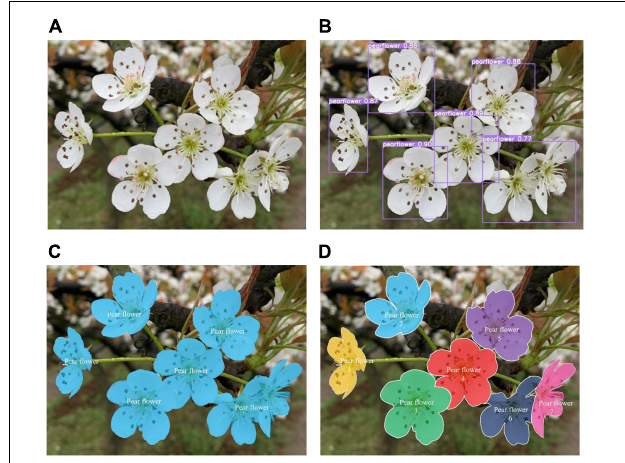
FIGURE 4 | Different CNN-based algorithms for pear flower detection. (A) Original image, (B) object detection, (C) semantic segmentation, and (D) instance